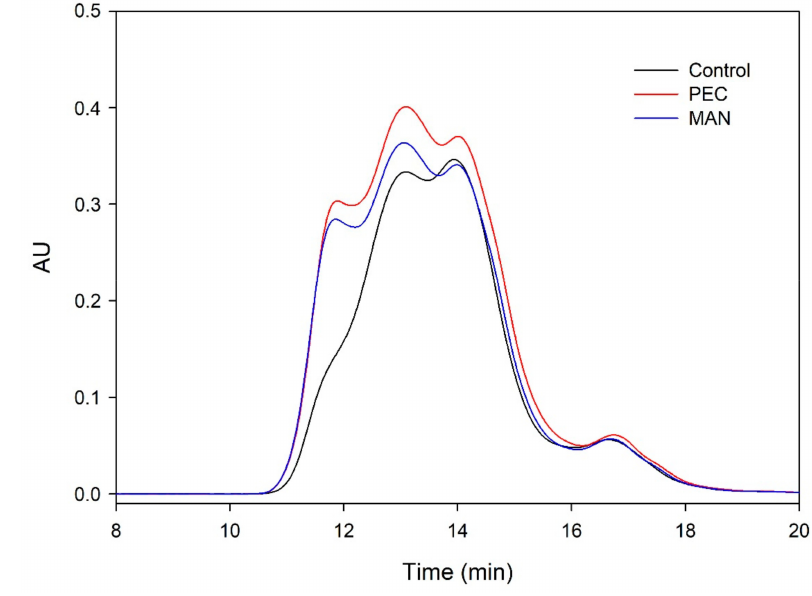
Figure 10. Mass distribution of the proanthocyanidins of the final wines analyzed by SEC after six months of aging in the bottle.